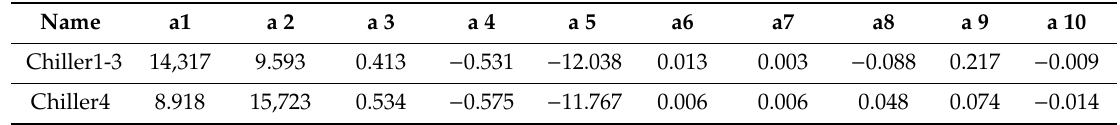
Table 3. Chiller model parameters.